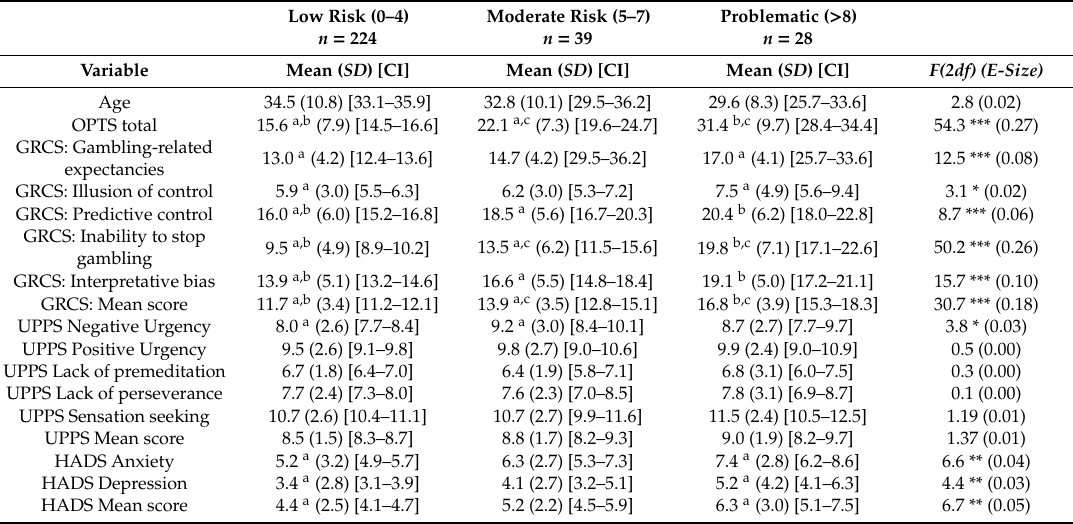
Table 2. Means comparisons of the three groups of gamblers with one-way